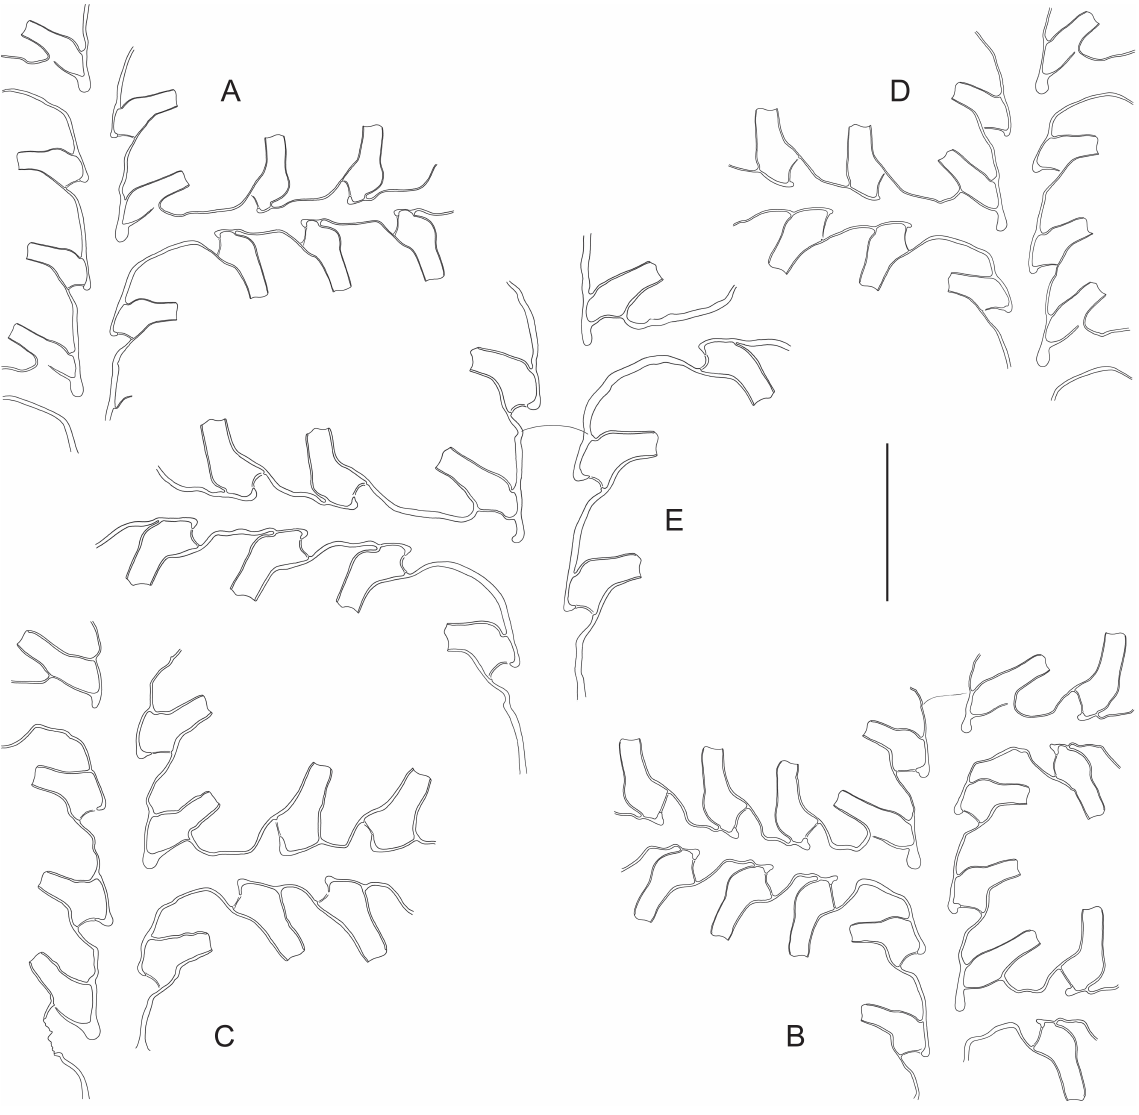
Fig. 2. ― A . Gonaxia amphorifera Vervoort, 1993 (SMIB 6, Stn. DW127), portion of stem with cladium. ― B . Gonaxia ampullacea Vervoort, 1993 (BATHUS 4, Stn. DW914), portion of stem with cladia. ― C . Gonaxia compacta Vervoort, 1993 (BATHUS 4, Stn. DW923), portion of stem with cladium. ― D . Gonaxia intermedia Vervoort, 1993 (BATHUS 4, Stn. CP906), portion of stem with cladium. ― E . Gonaxia sinuosa Vervoort, 1993 (SMIB 4, Stn. DW40), portion of stem with cladia. Scale bar: A–E = 1